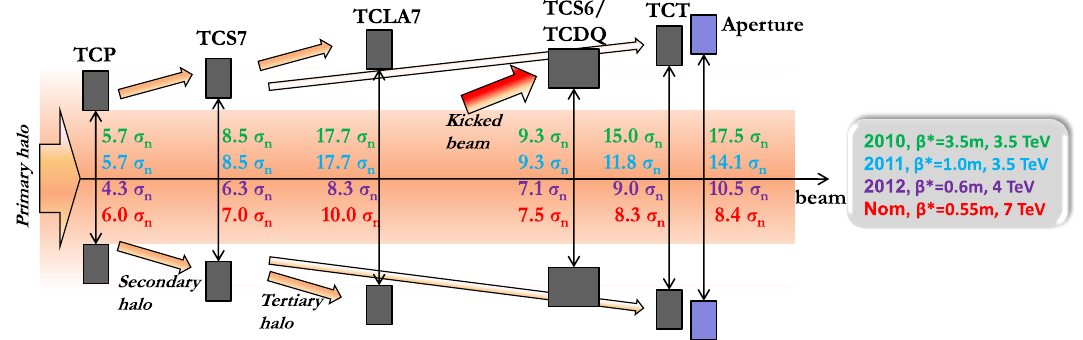
FIG. 3. Schematic illustration (not to scale) of the collimator settings and the minimum aperture that can be protected during the physics runs in 2010 (3.5 TeV), 2011 (3.5 TeV), and 2012 (4 TeV), together with the nominal settings (7 TeV). The resulting values of β (cid:1) are also